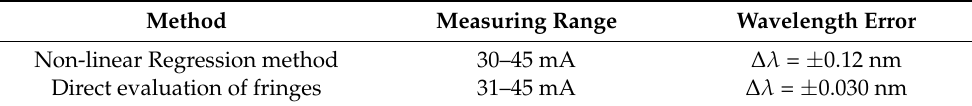
Table 1. Measuring ranges and wavelength errors of the two methods.